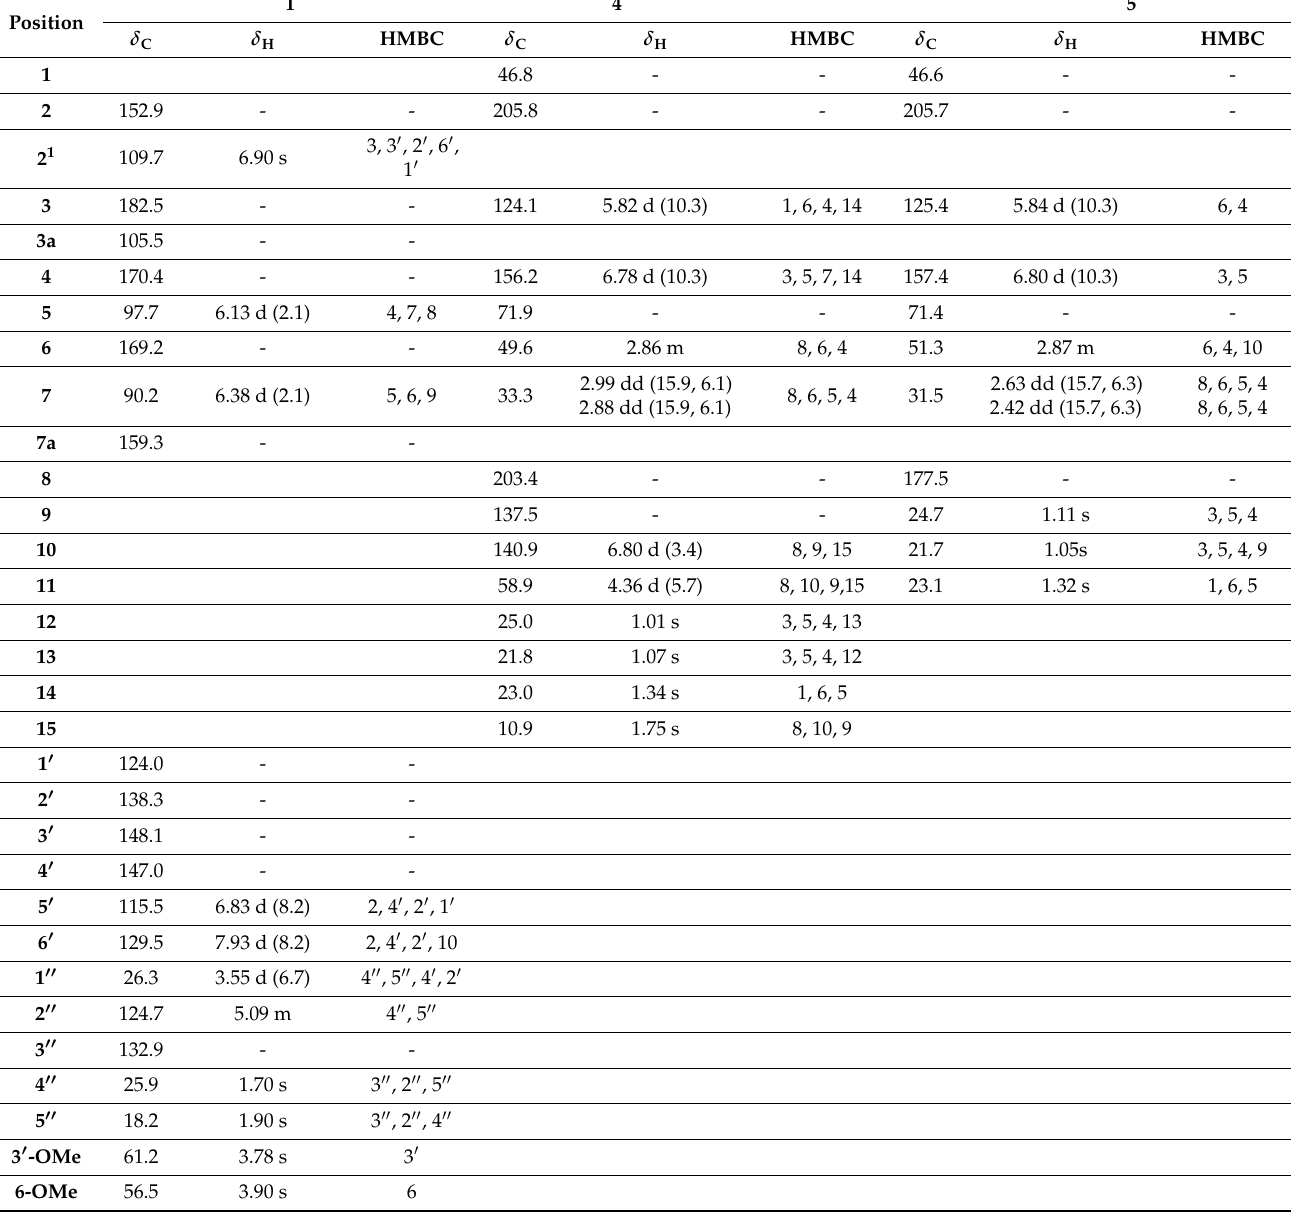
Table 1. 1 H- (500 MHz) and 13 C-NMR (125 MHz) data of 1 (CDCl 3 -CD 3 OD) and, 4 and 5 (CD 3 OD).